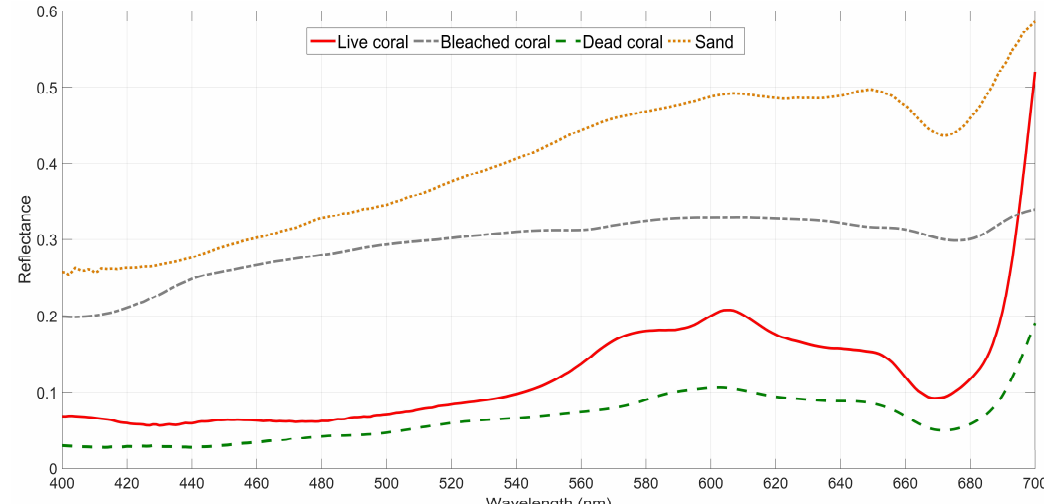
Figure 1. Full spectral reflectance data of benthic types measured in the field. Lines represent the mean spectral value for benthic types. spectral value for benthic types.